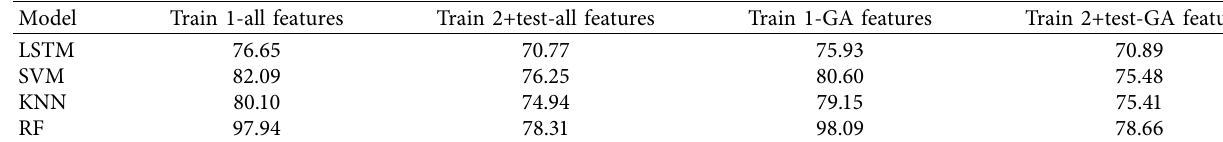
Table 5: Accuracy of predictions of single models.